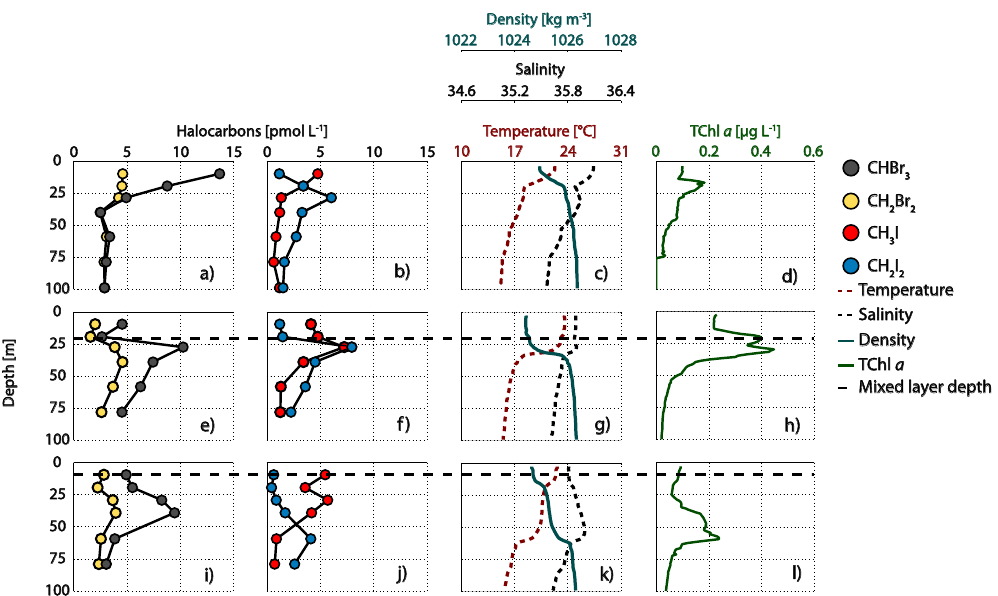
Figure 3. Selected CTD profiles (top – down: profiles 7, 9 and 10, see Fig. 1 for the location) of CHBr 3 , CH 2 Br 2 , CH 3 I, and CH 2 I 2 in (a–b, e–f) , and (i–j) , along with temperature, salinity, and density (c, g, k) , as well as T Chl a in (d) , (h) , and (l) , and the mixed layer depth as black dashed line at the same stations.